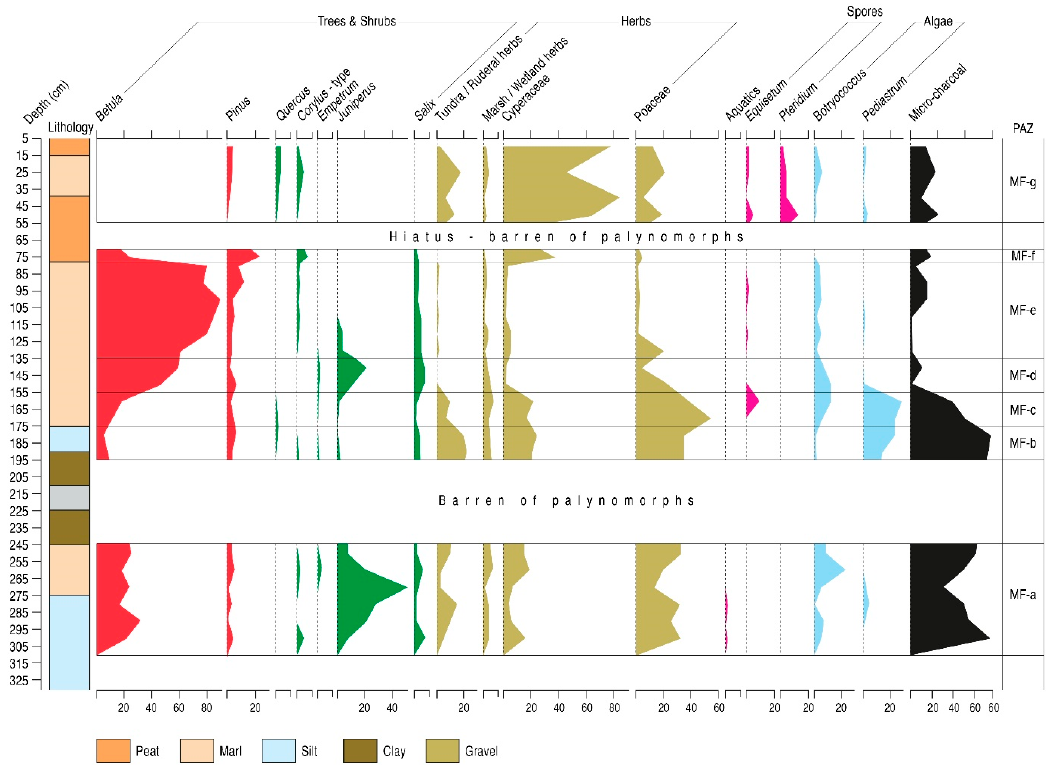
Figure 4. Summary pollen diagram from Marfield. Frequencies are calculated as percentages of total land pollen. For lithology, see Table 2.